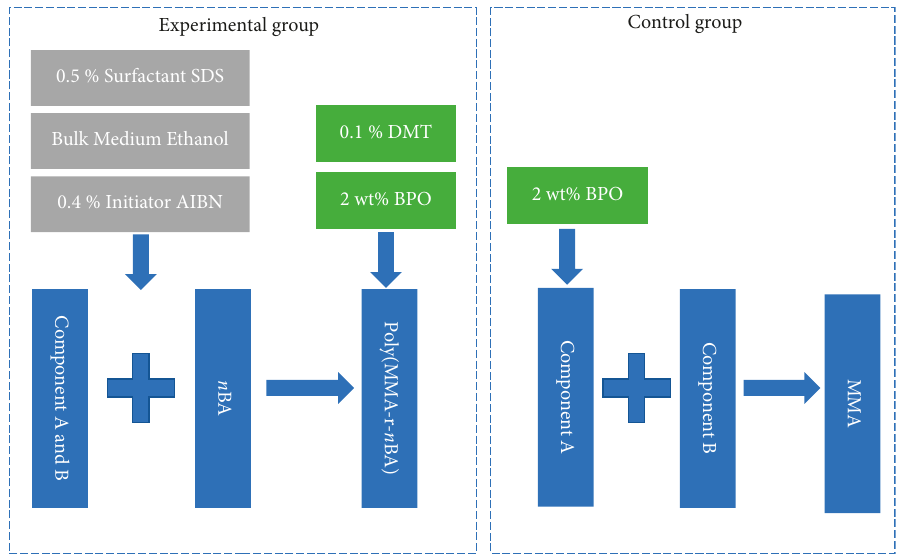
Figure 1: Experimental plan for sample preparation. Table 1: The parameters of poly(MMA-r-nBA) atomistic